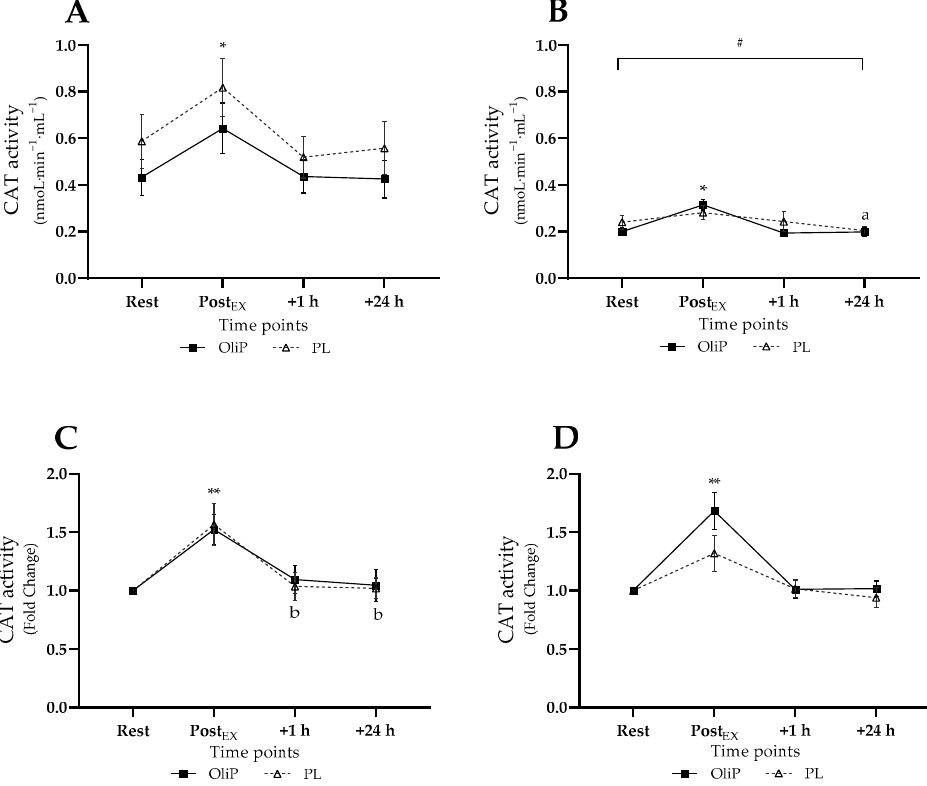
Figure 4. Plasma catalase (CAT) activity expressed in mean absolute (nmoL · min − 1 · mL − 1 ) and fold change terms in participants that were supplemented with OliPhenolia ® (OliP) for 16 consecutive days or with a matched placebo (PL). ( A , C ) Pre-intervention, before supplementation; ( B , D ) Post 16-day supplement intervention. * denotes difference PostEx to all other timepoints within both OliP and PL pre-intervention, but only OliP post-intervention ( p ≤ 0.04); a denotes difference compared with PostEx within PL only ( p = 0.044); ** denotes difference within trial compared with rest ( p ≤ 0.006), and all timepoints within OliP post-intervention ( p ≤ 0.003); b denotes difference to PostEx within PL only ( p ≤ 0.032); # all significantly different to comparative timepoint pre-intervention within both PL and OliP ( p ≤ 0.024).